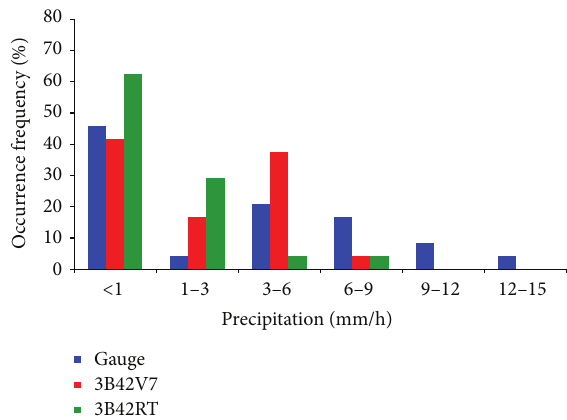
Figure 3: Station-based gauge and 3B42V7/3B42RT three-day accumulated precipitation.